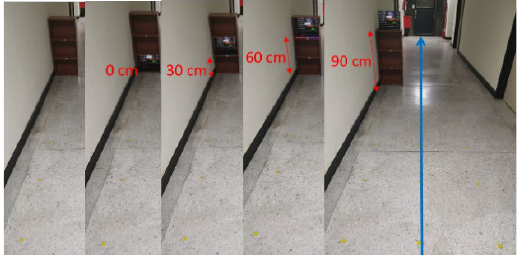
Figure 10. The photo of experiment